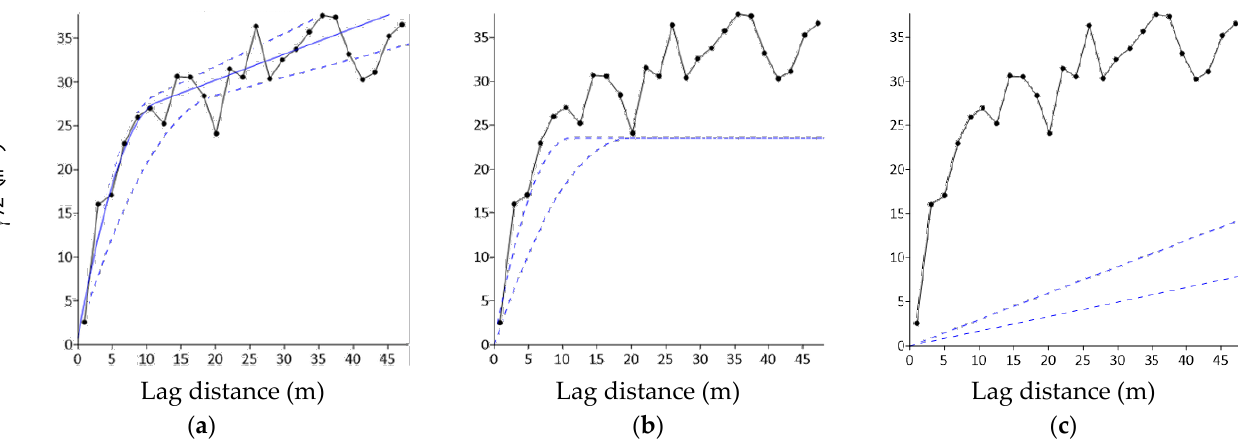
Figure 11. The empirical semivariogram of the H (black line with dots), with over-imposed closest theoretical semivariogram (blue continuous line); the range of variability of the theoretical semivari- ogram (dashed blue lines): ( a ) all the components of the semivariogram; ( b ) the quadratic model; ( c ) the linear model. Table 1. The Semivariogram components' parameters: ( a ) CHM and ( b ) H . Nugget